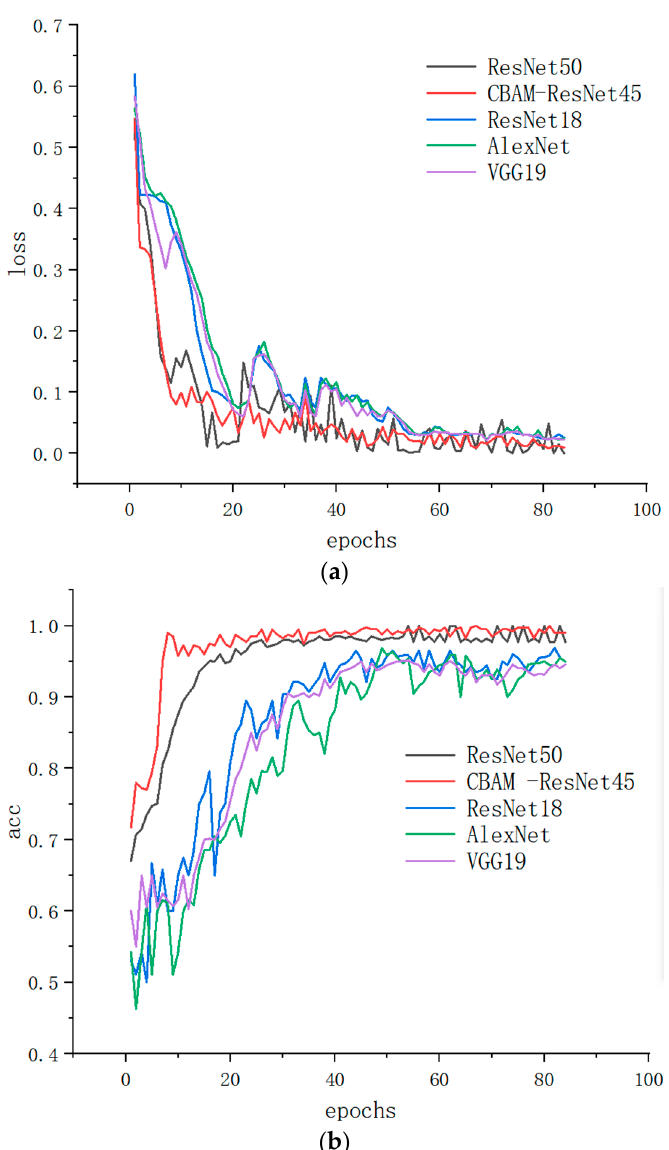
Figure 9. Training results of models. ( a ) Training loss rate curve of the models. ( b ) The training accuracy curve of the models.